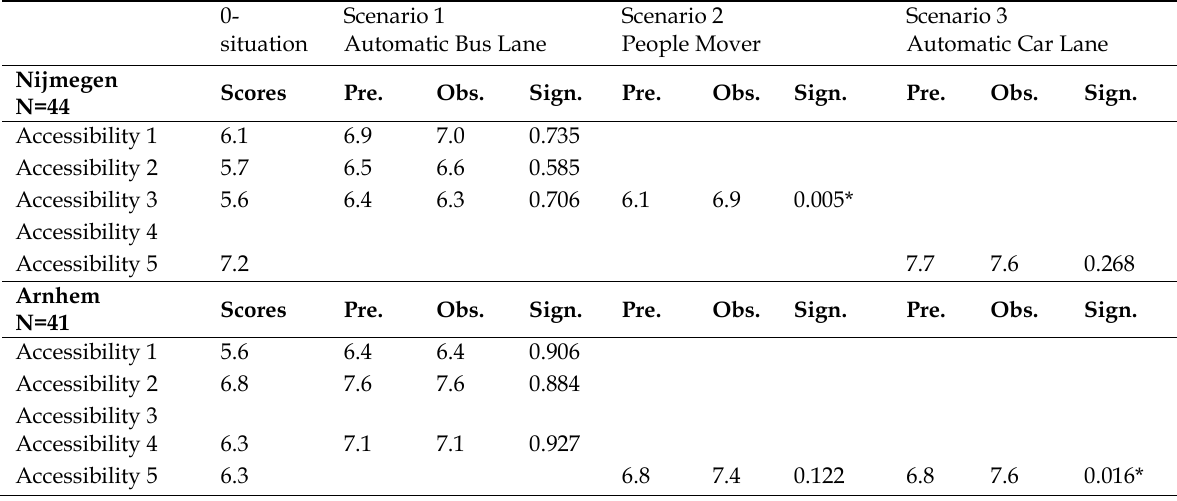
Table 6. Predictions for accessibility scores for ITS